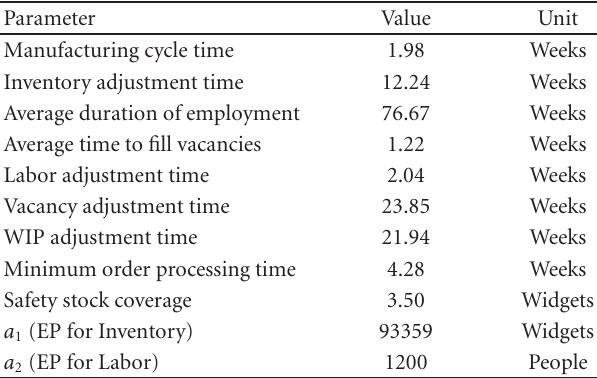
Table 3: Parameter values for policy using PSO algorithm.